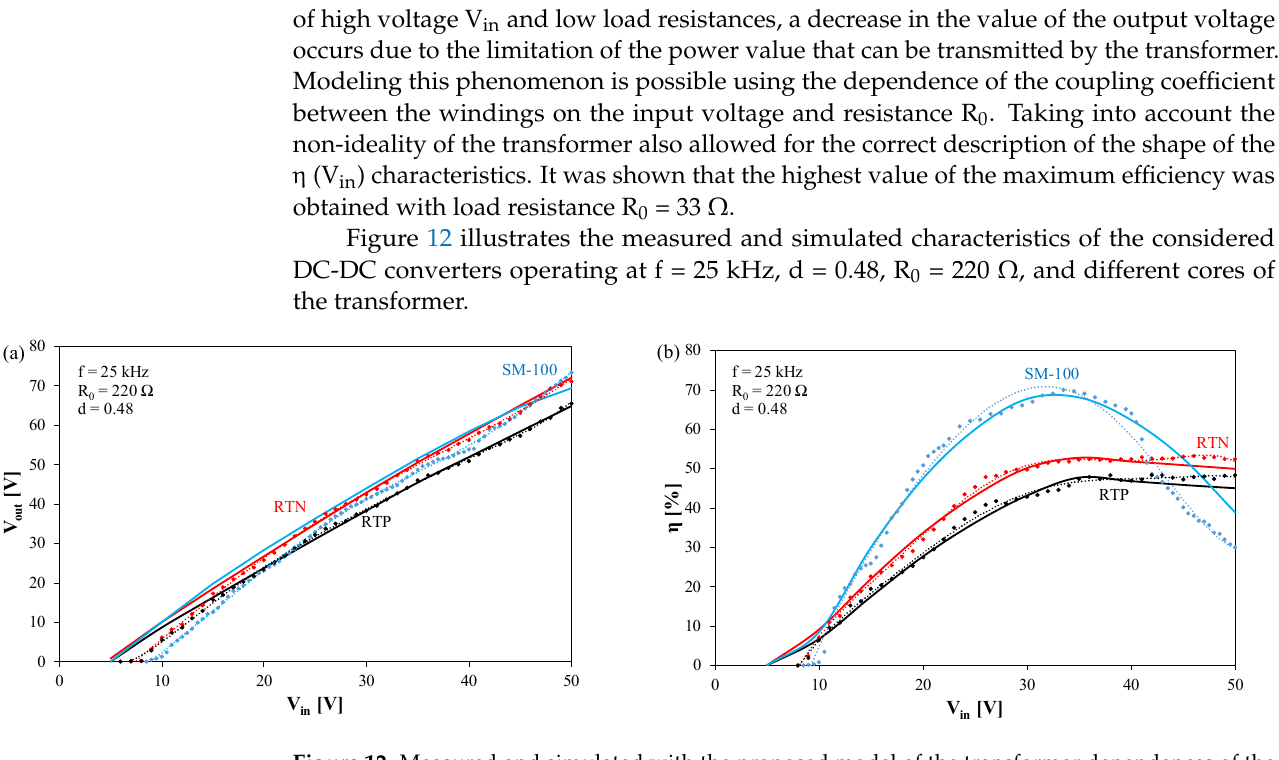
Figure 12. Measured and simulated with the proposed model of the transformer dependences of the output voltage ( a ) and energy efficiency ( b ) of the tested DC-DC converter on its input voltage at f = 25 kHz and R 0 = 220 Ω .